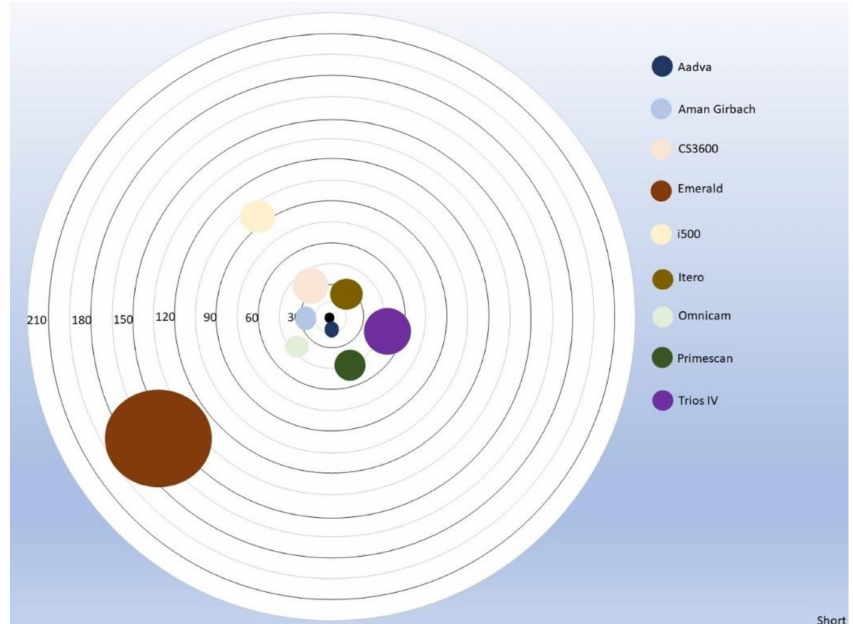
Figure 5. The distance of the circles to the center represents the “trueness” whereas the diameter of the circles represents “precision” for the short distances.